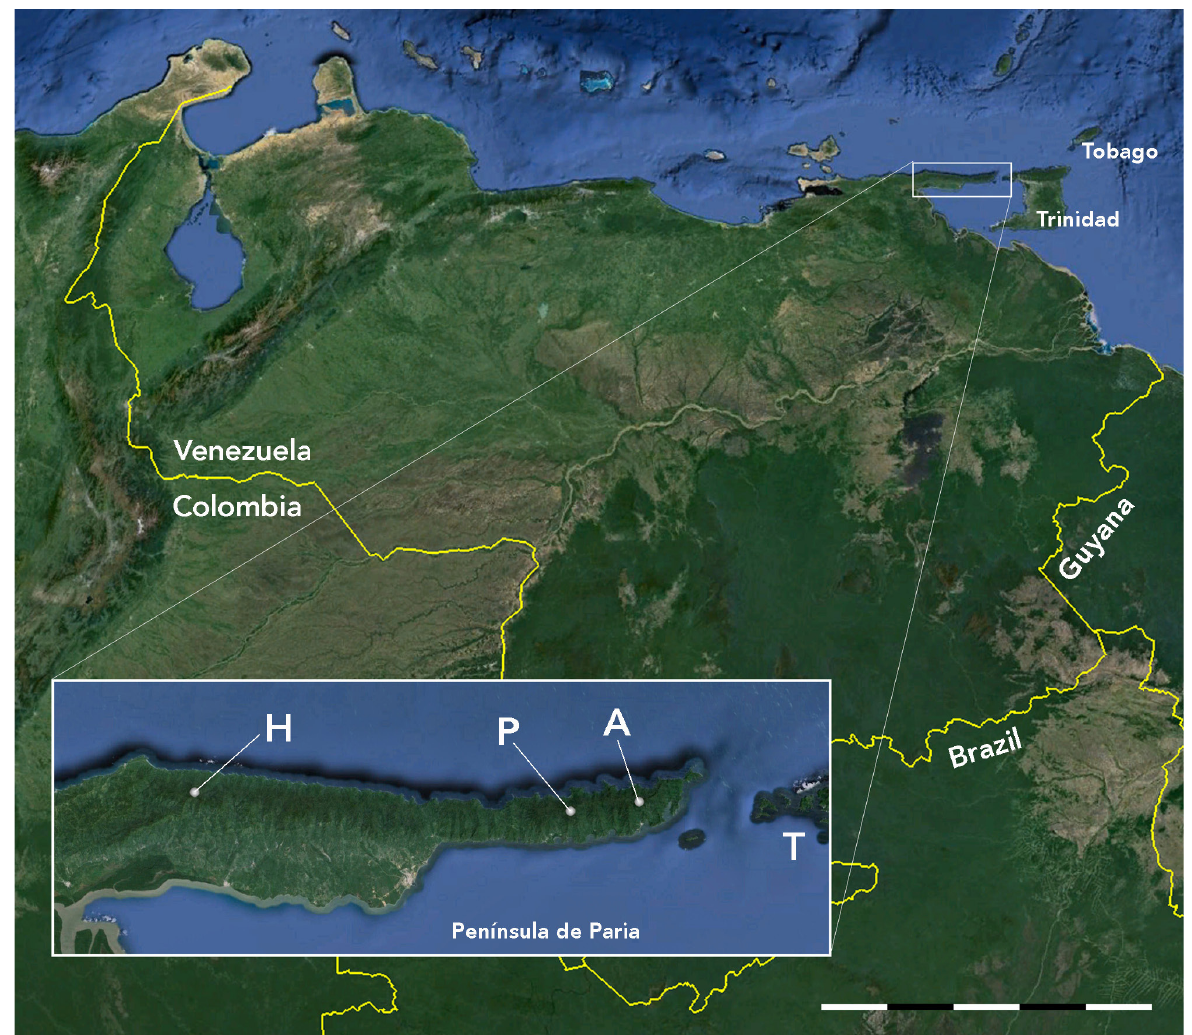
Image 1. Satellite map of Venezuela and surrounding areas. The location of the Península de Paria is indicated by the rectangle in the upper right-hand corner of the map. The inset shows a close-up of the peninsula and adjacent Trinidad (T), with three important centers of endemism indicated by labeled points: Cerro Humo (H), Cerro Patao (P), and Cerro Azul (A). Scale = 500km. Map produced from Google Earth